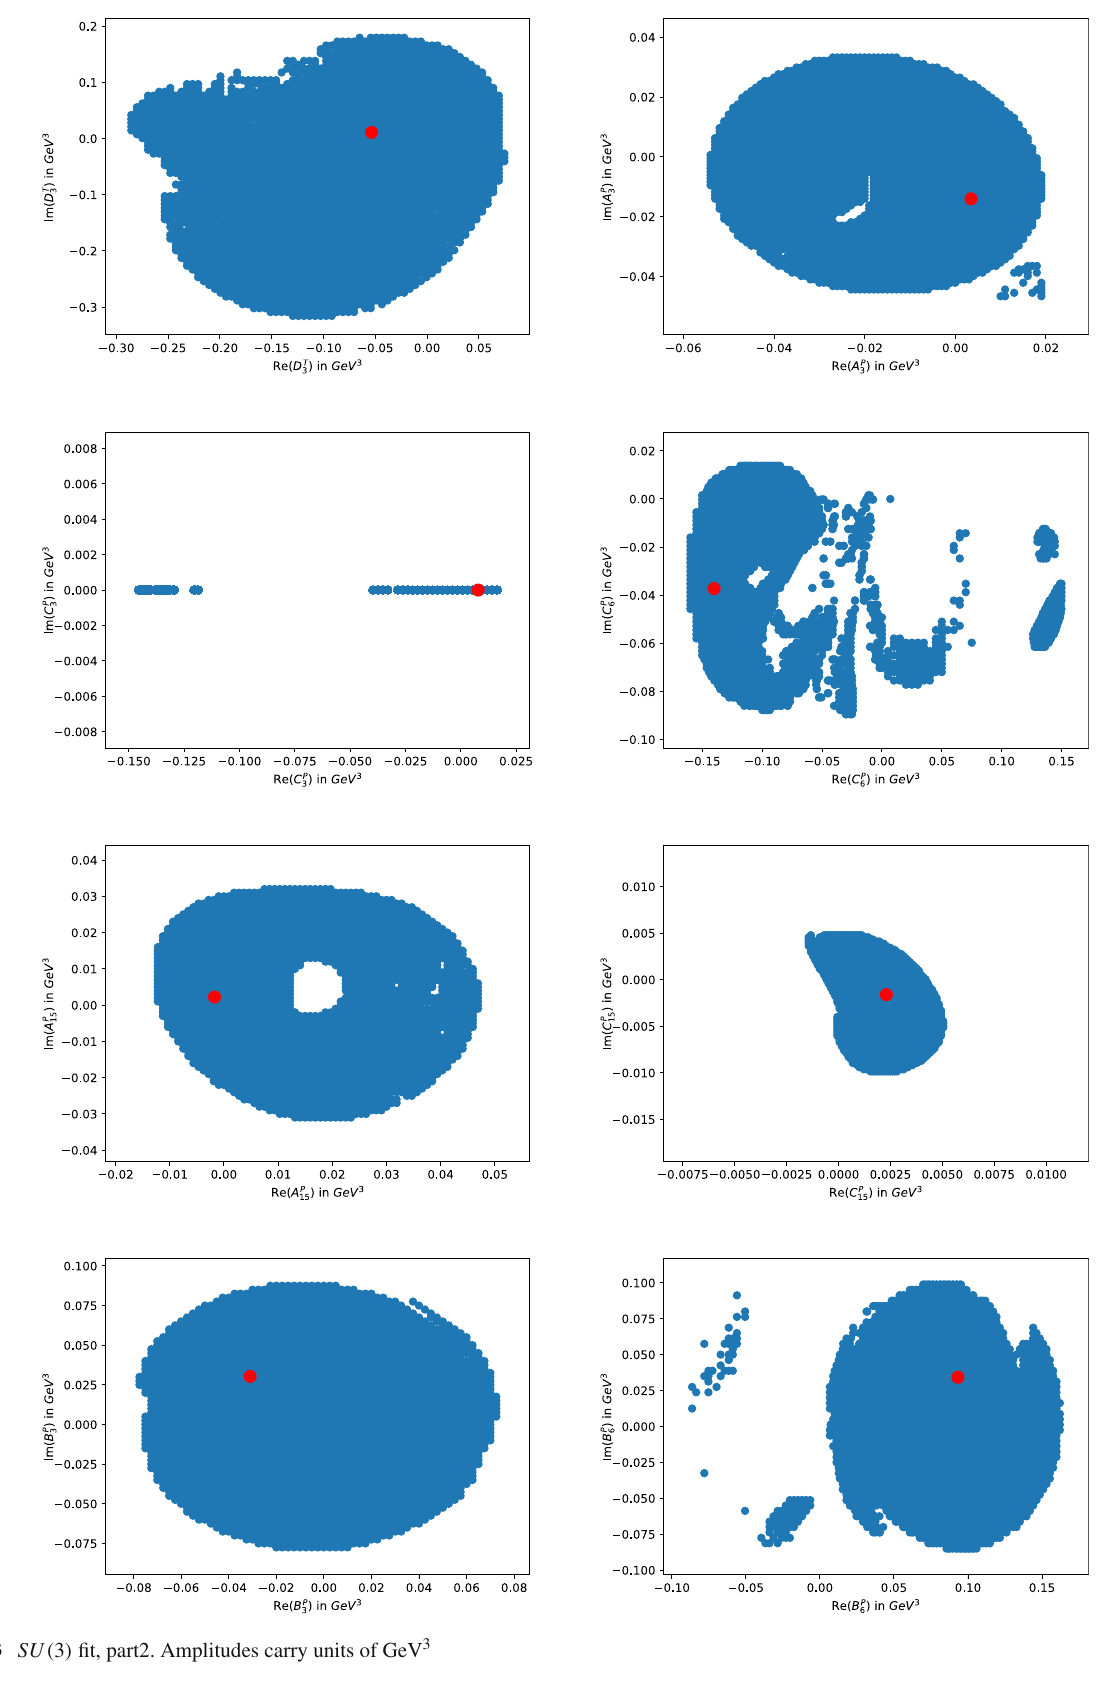
Fig. 3 SU ( 3 ) fit, part2. Amplitudes carry units of GeV